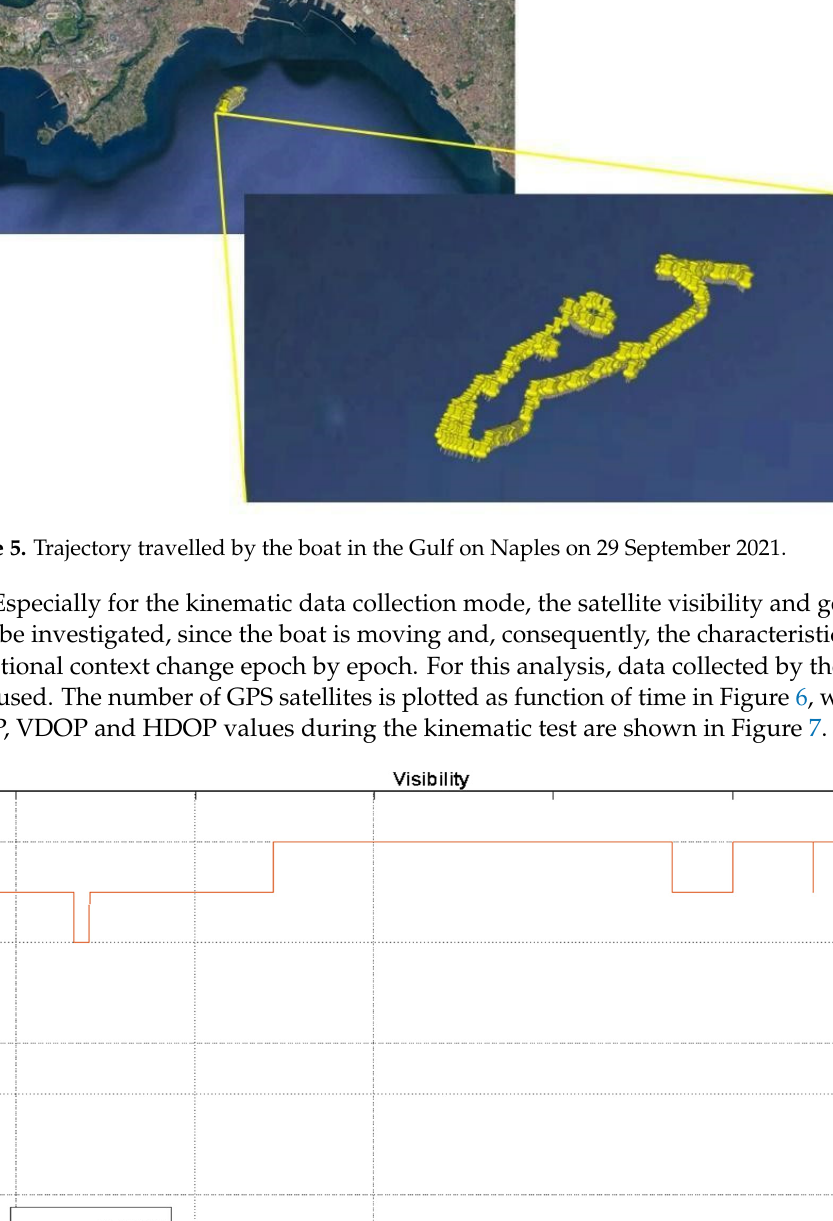
Figure 6. Number of visible GPS satellites during the kinematic test.